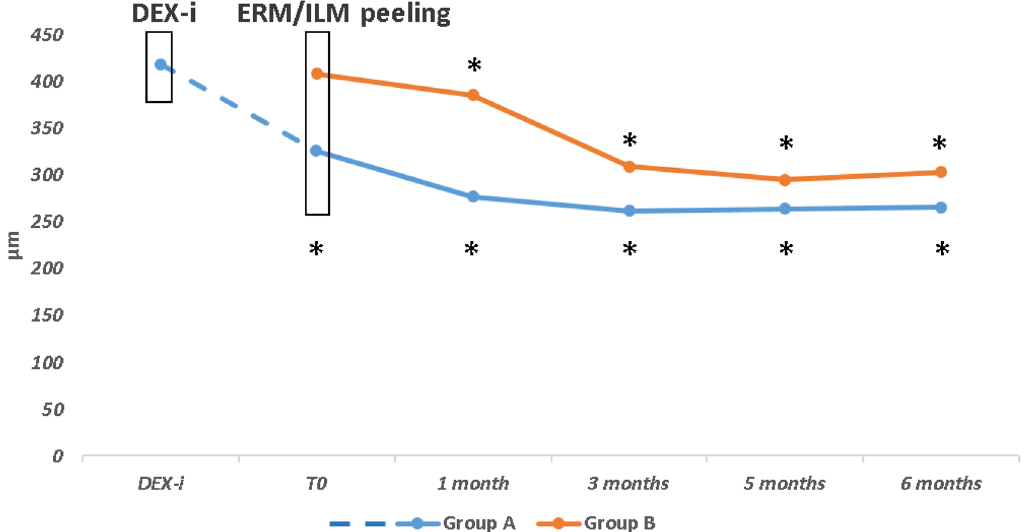
Figure 3. Mean Central retinal thickness (CRT) in Groups ( A and B ) over the study follow-up. DEX-i, intravitreal dexamethasone implant; ERM/ILM, Epiretinal Membrane/Inner Limiting Membrane; * P < 0.001 as compared to T 0 within each group.